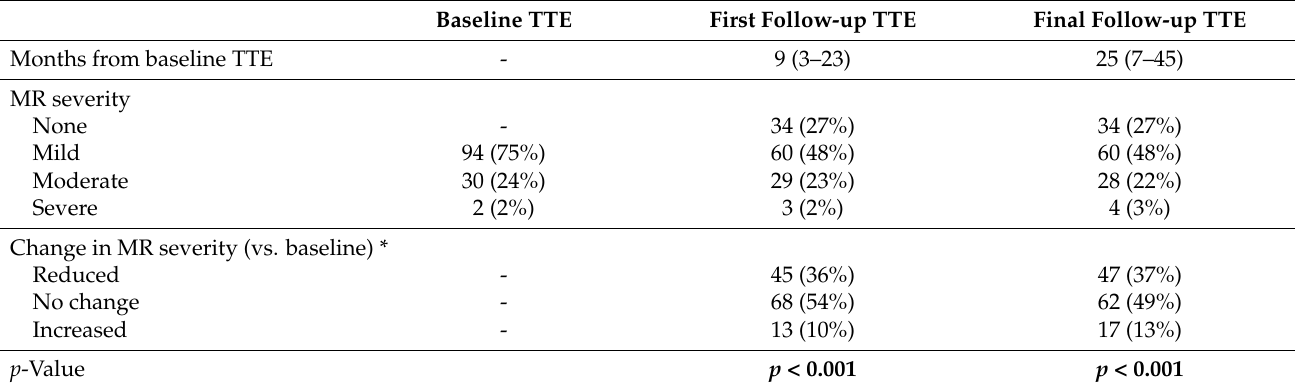
Table 2. Changes in MR severity.